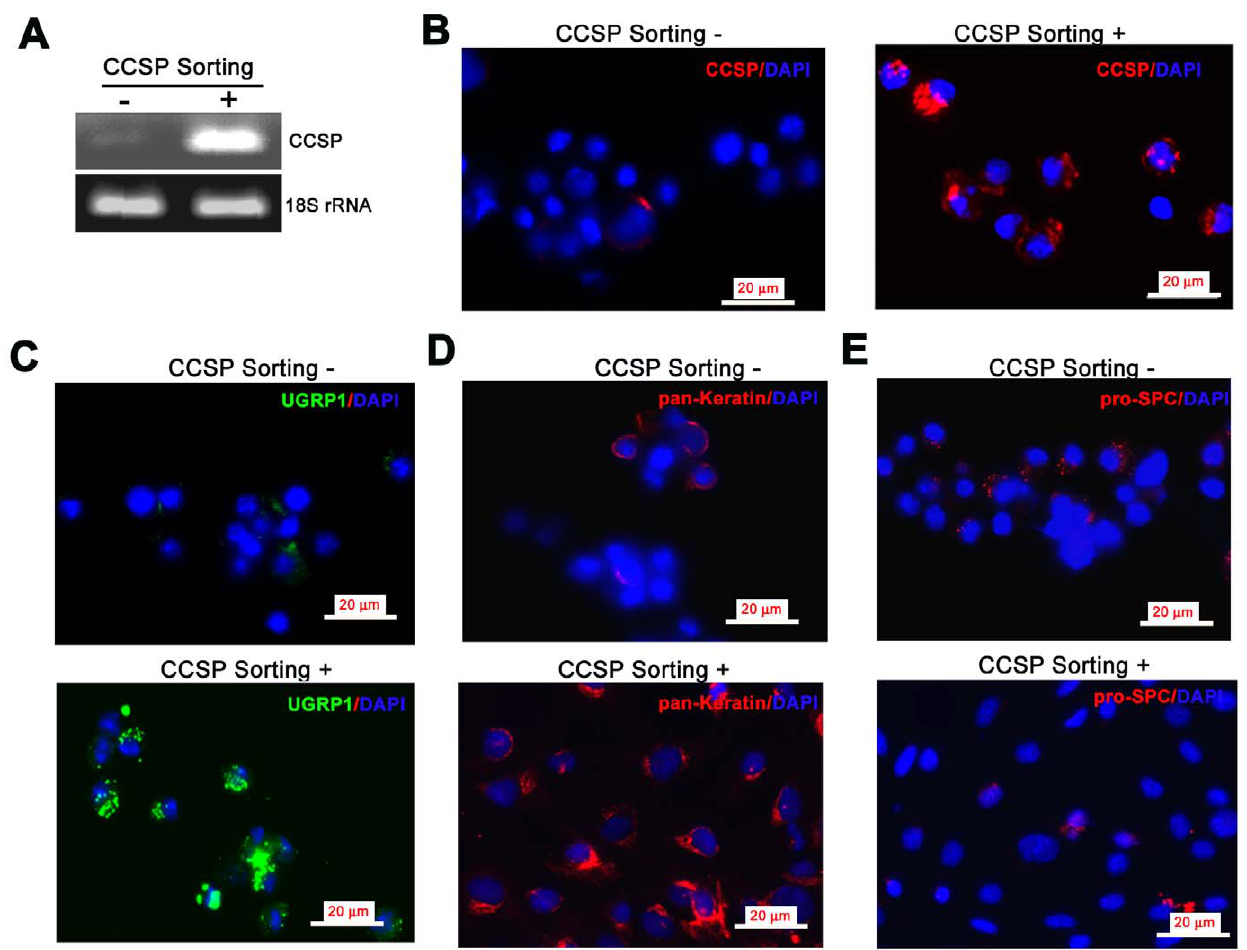
Figure 3. Characterization of sorted cells. A) RT-PCR of sorted cell fractions with minimal (CCSP 2 fraction) and strong (CCSP + fraction) expression of CCSP mRNA. B–E) Immunofluorescence staining of sorted cell fractions. B) CCSP (green fluorescence) was expressed in almost all cells of the CCSP + fraction, but rarely in the CCSP 2 fraction. C) Many cells were also positive for the Clara cell marker UGRP1 (green fluorescence) in CCSP + fraction cells. D) Pan-keratin expression (red fluorescence) in CCSP + cells confirmed that they were epithelial. Only small population of CCSP 2 cells expressed pan-keratin. E) Few cells in either fraction expressed pro-SPC (red fluorescence). Nuclei appear blue (DAPI); Bar=20 m m; CCSP Sorting negative=CCSP 2 fraction; CCSP Sorting positive=CCSP +